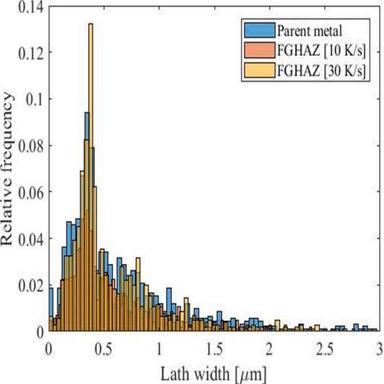
Measured block diameter distributions in X100Q PM, FGHAZ (10 K/s), and FGHAZ (30 K/s) from EBSD data.